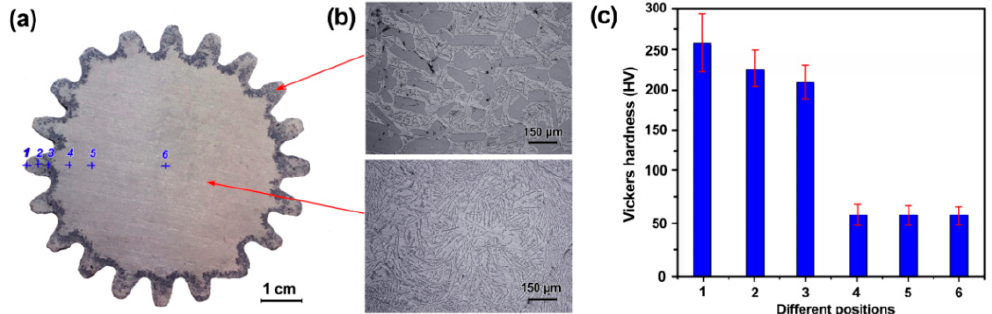
Figure 9. ( a ) Cross-section images of hypereutectic Al-18Si in-situ graded gear, ( b ) microstructures of the Si-poor region and the Si-rich layer, ( c ) Vickers hardness values for different positions.